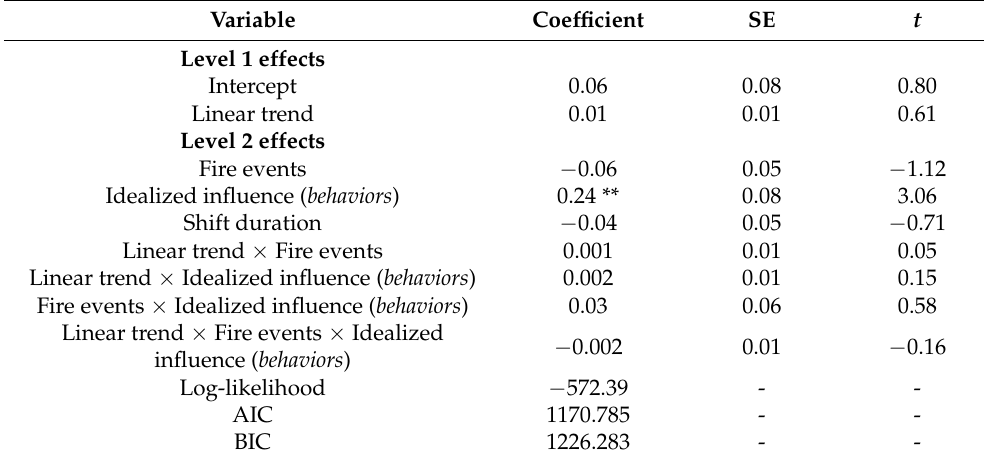
Table A1. Fire Events and Idealized Influence (Behaviors) Predicting Change in Work